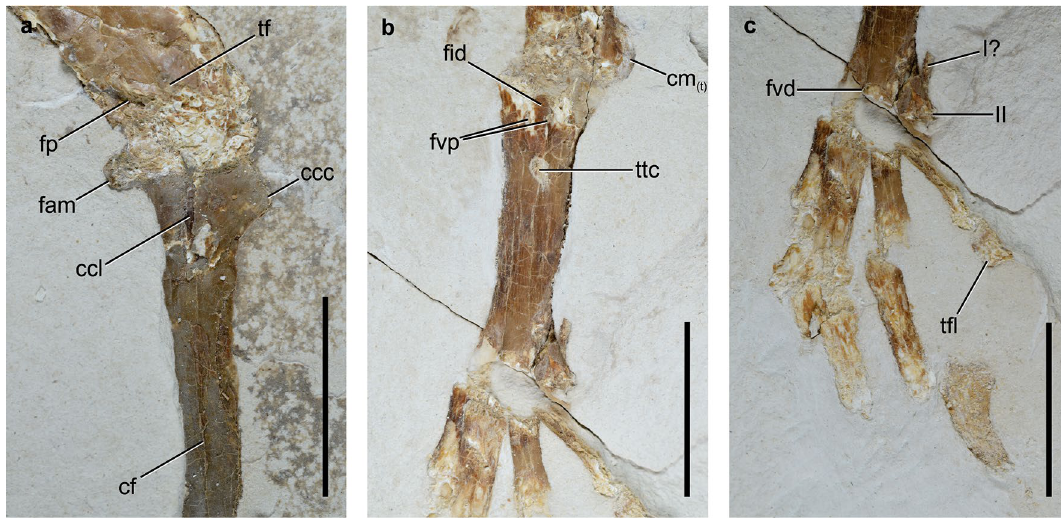
Figure 2. Ueekenkcoracias tambussiae gen. et sp. nov., holotype MPEF-PV 10991. ( a ) detail of the proximal end of tibiotarsus; ( b ) tarsometatarsus; ( c ) detail of the foot. ccc crista cnemialis cranialis, ccl crista cnemialis lateralis, cf crista fibularis, cm (t) condylus medialis (tibiotarsus), fam facies articularis medialis, fid fossa infracotylaris dorsalis, fp fossa poplitea, fvd foramen vasculare distale, fvp foramina vascularia proximalia, I? metatarsi